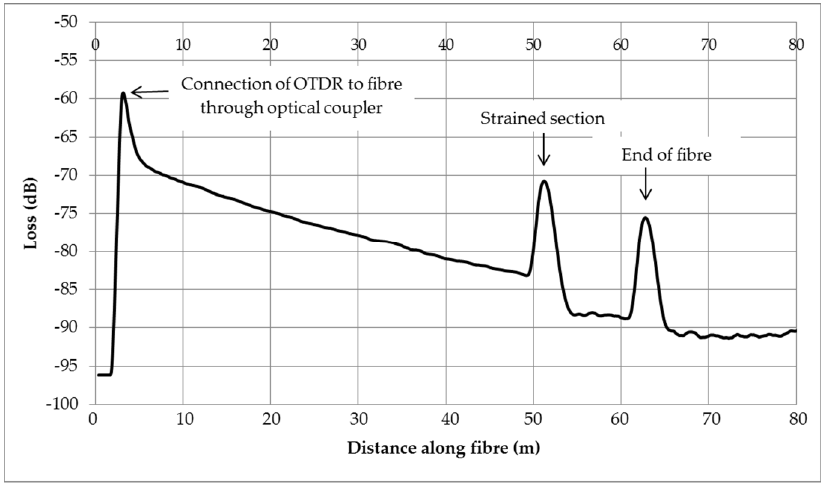
Figure 16. Full OTDR plot detailing gauge length strained at 80%. Key events are highlighted.